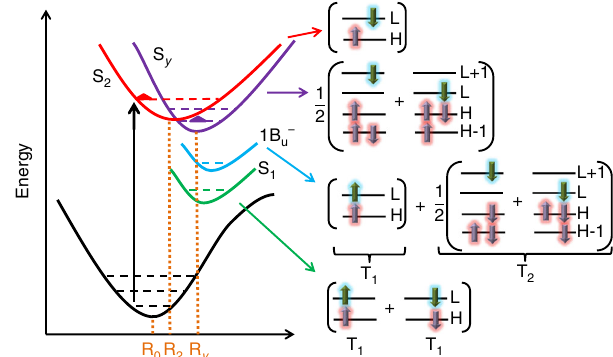
Fig. 3 Scheme of the potential energy curves for carotenoids with N ≥ 9 ( left ) and the compositions of excited states ( right ). R 0 , R 2 , and R y represent geometries at the potential minima of states S 0 , S 2 , and S y , respectively. H and L represent the highest occupied and the lowest unoccupied molecular orbitals, respectively. Arrows on the orbital illustrate the population and the spins of electrons in this orbital. S 2 and S y are singly excited states. S 1 (formed by two T 1 ) and 1B u − (formed by T 1 and T 2 ) are doubly excited states. T 1 and T 2 are the lowest and the second lowest triplet exciton, respectively by 0.66 eV for RG and 0.68 eV for spirilloxanthin, respectively (Fig. 3). Now, at the potential minimum of the S 2 state, the energy of the S y state is just a little bit higher (0.07 eV for RG and 0.02 eV for spirilloxanthin) than the S 2 state. If extrapolating further along the R 0 → R 2 reaction coordinate, the energy of the S y state falls by an additional 0.1 eV (Fig. 3). The emission energy of the S y state (at R y in Fig. 3) is thus lower than that of the S 2 state (see also Supplementary Figs. 8 and 9; Supplementary Note 4).